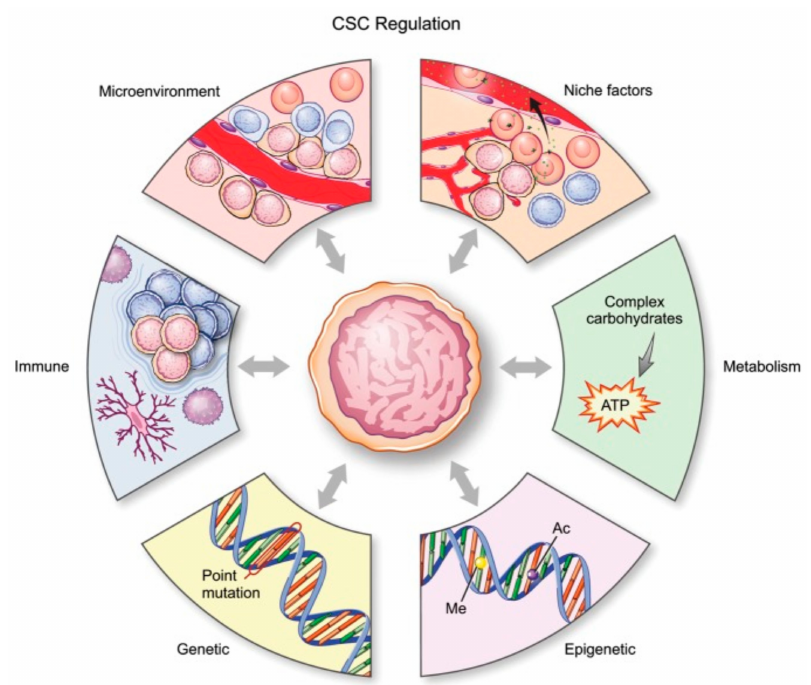
Figure 1. Schematic representation of all processes affecting glial stem cells (GSCs). [17]. CSC, cancer stem cell. License of this figure provided at https://creativecommons.org/licenses/by-nc/4.0/ (accessed on 19 February 2021). Changes made: figure